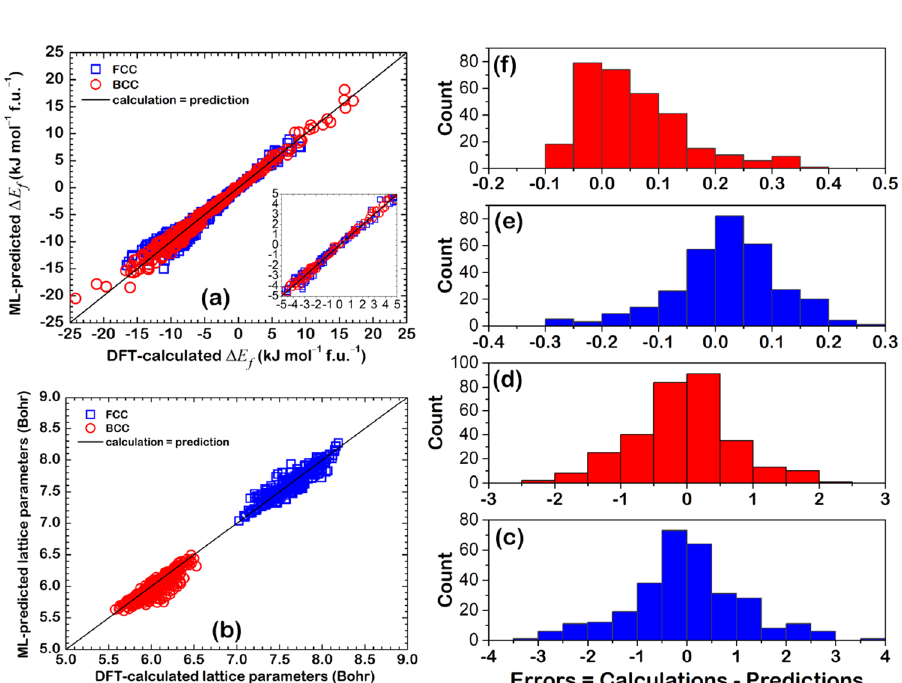
Figure 10. Validation of PtPdCr XY , PtPdNiSn X , and PtPd XYZ HEAs including regression plots of ( a ) formation energy, ( b ) lattice parameters, ( c ) error of formation energy in FCC data, ( d ) error of formation